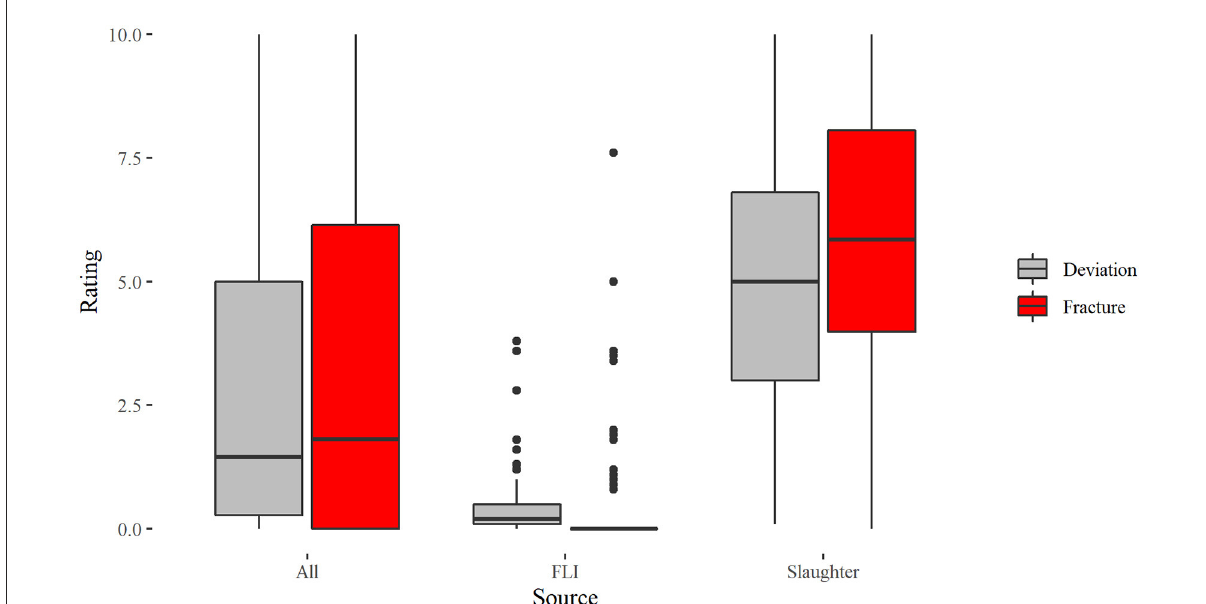
FIGURE3 Boxplots for the scoring of deviations and fractures in laying hens assessed on 192 x-rays differentiated according to the total sample “All,” keels sampled from FLI and keels sampled from slaughterhouse